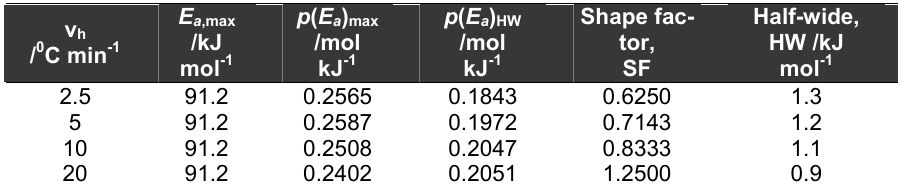
Table 5 – The influence of the heating rate (v h ) on the basic characteristics of the density distribution function of the apparent activation energies (ddfE a ’s), p(E a ), for the reduction process of nickel oxide under hydrogen